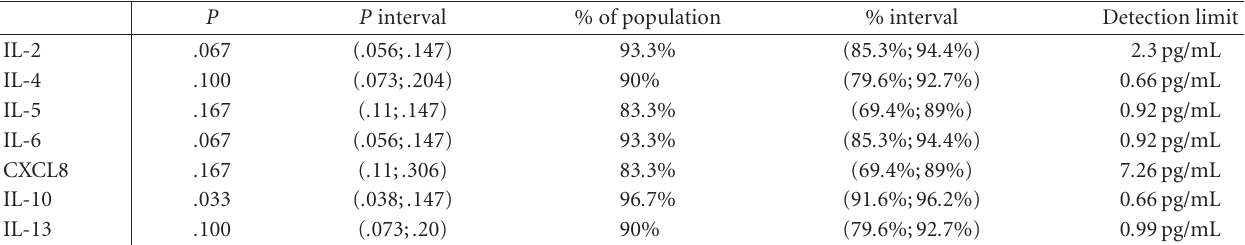
Table 1: Probabilities of occurence of detectable level of particular interleukin in plasma of healthy blood donors. P is probability of nonzero values occurence of interleukin and confidence interval at 5% level, % of population shows proportion of blood donors with nondetectable level of particular interleukin and confidence interval at 5% level, and detection limit shows limit for detecting particular interleukin in ELISA assay.